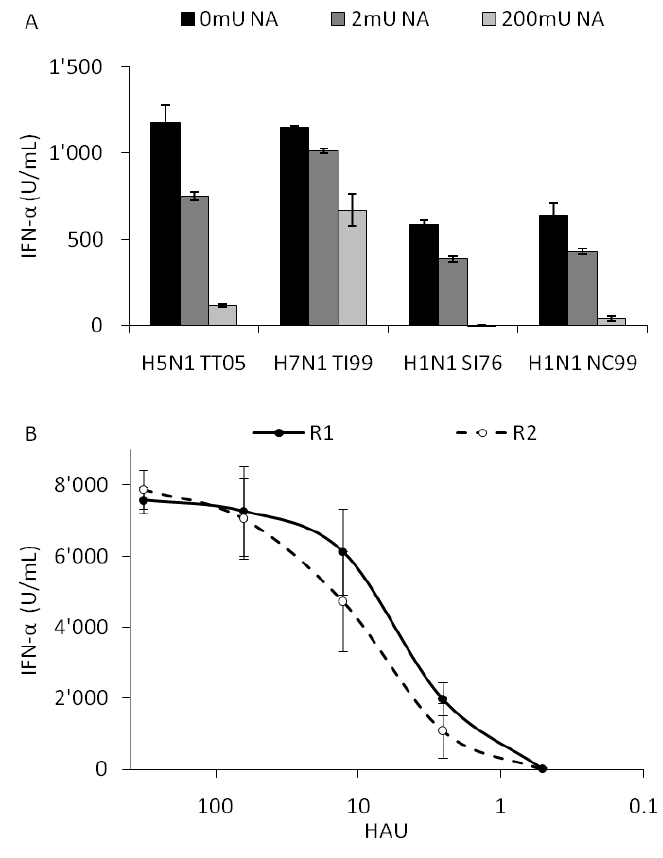
Figure 5. Role of sialic acid (SA) residues for IFN-  responses by pDC. ( A ) Porcine pDC were treated with 0, 2 or 200 mU of NA for 1 h, infected at a 100 HAU dose and supernatants harvested after 24 h for IFN-  quantification. ( B ) pDC were stimulated at a various HAU doses with the SA specific virus pair R1 and R2, which possess mammalian α-2,6 SA or avian-like α-2,3 SA receptor specificity, respectively. IFN-α was quantified in the supernatant by ELISA. Error bars represent the standard deviation of triplicate